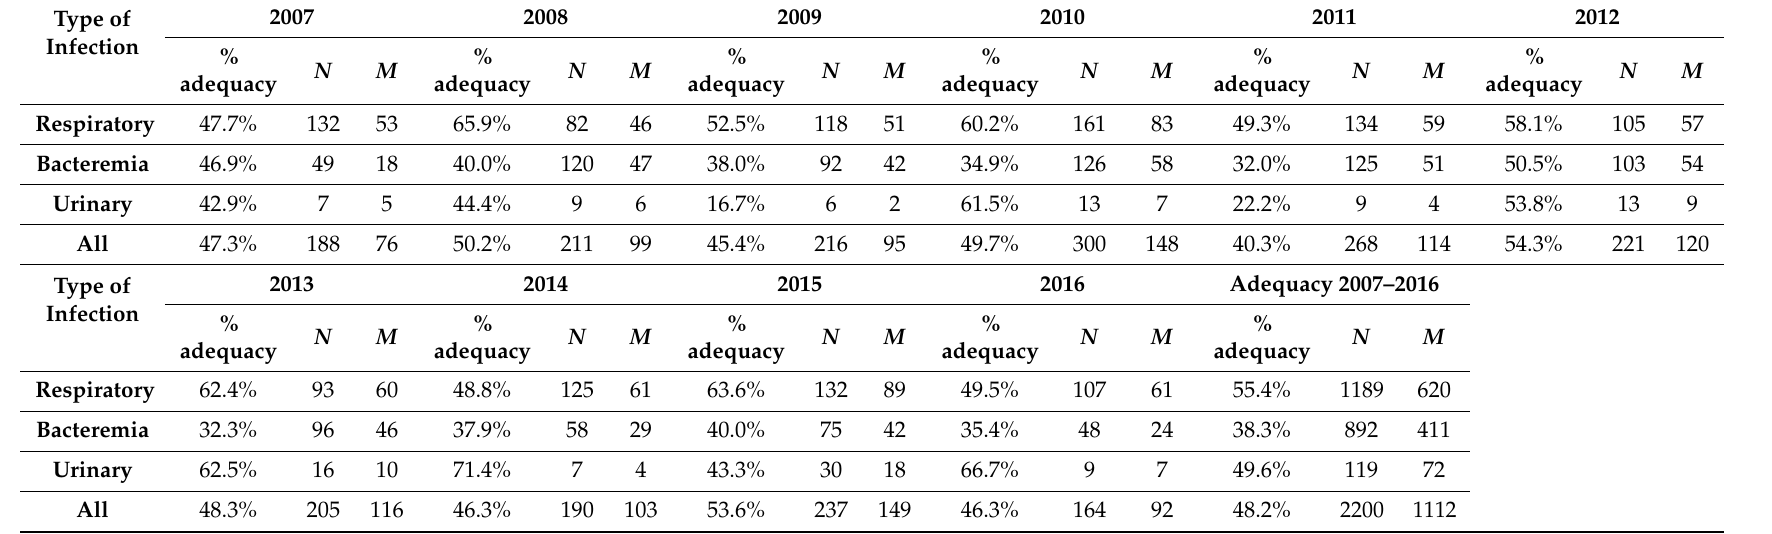
Table 5. Percentage adequacy of empirical antibiotic treatment by year and by type of